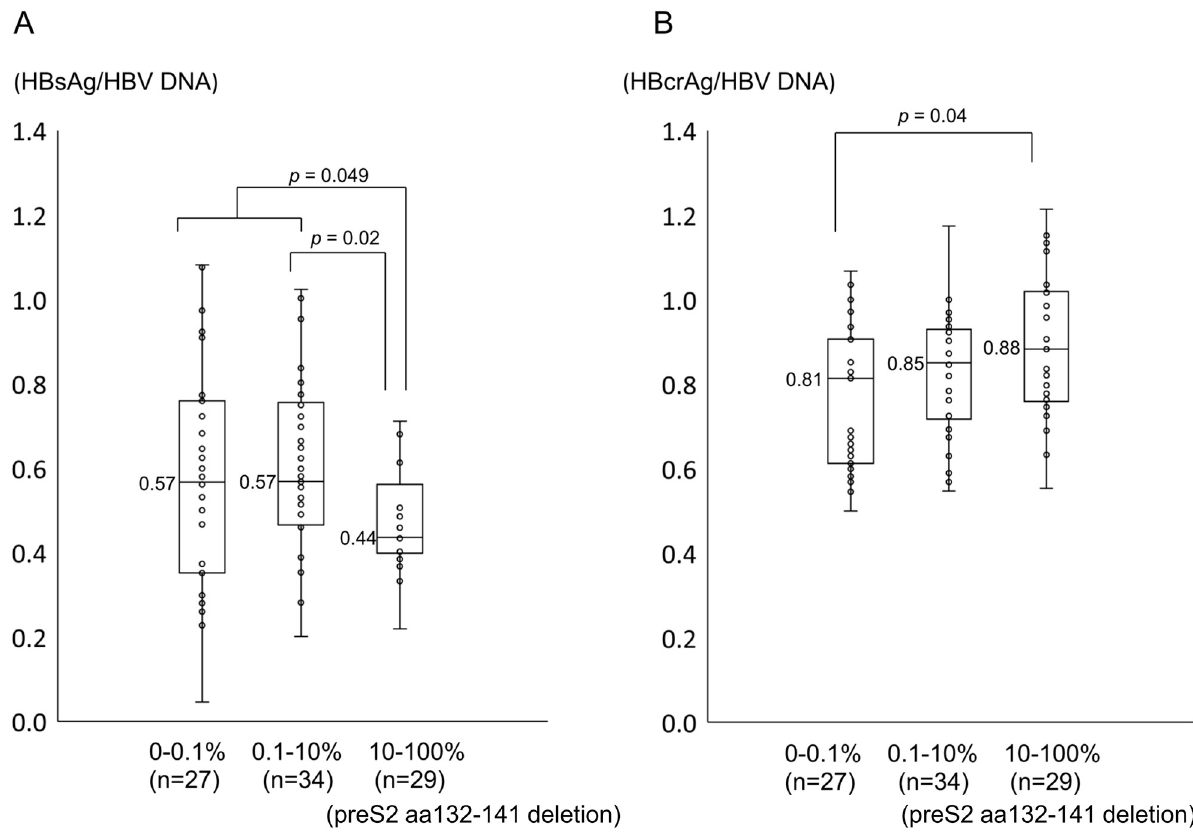
Fig 5. The impact of preS codon 132–141 deletions on the serum HBsAg and HBcrAg titers, relative to the serum HBV DNA level. Left panel, the HBsAg titer relative to the HBV DNA value was significantly lower in cases with high frequencies of mutations (10–100%) than in those with low frequencies. Right panel, the HBcrAg titer relative to the HBV DNA value was significantly higher in cases with high frequencies of mutations (10– 100%) compared to those with low frequencies (0–0.1%).